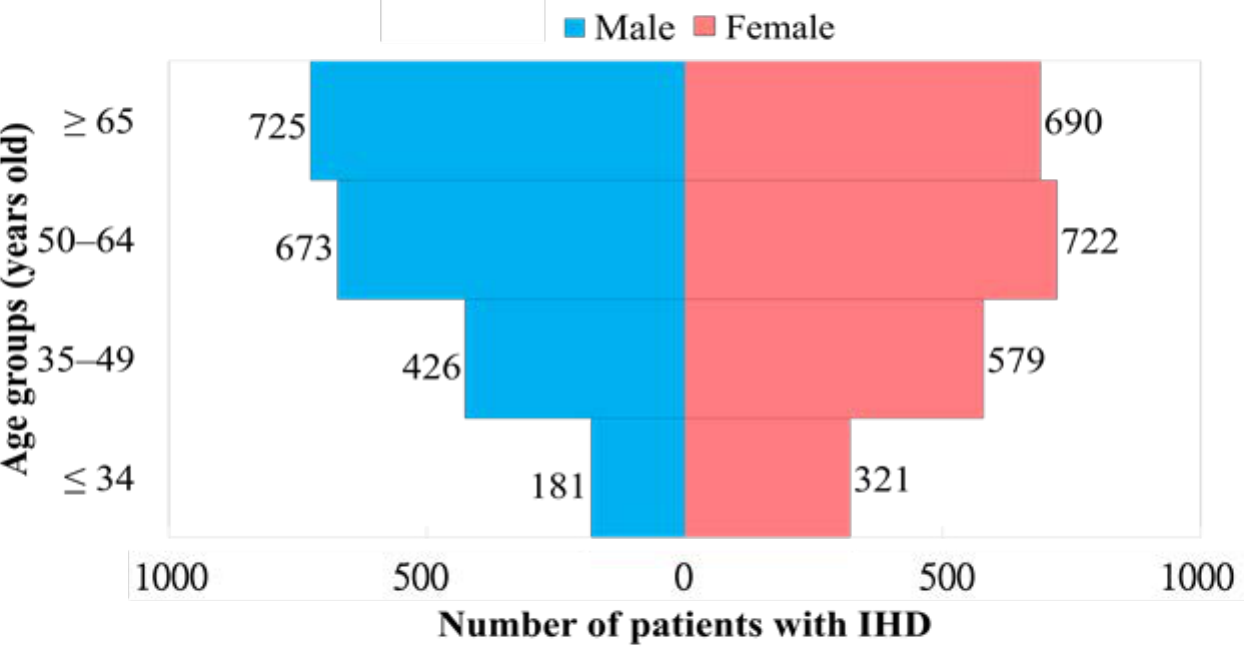
Figure 1. Relationship between the number of patients with ischemic heart disease (IHD) and age groups (total patient number, n =